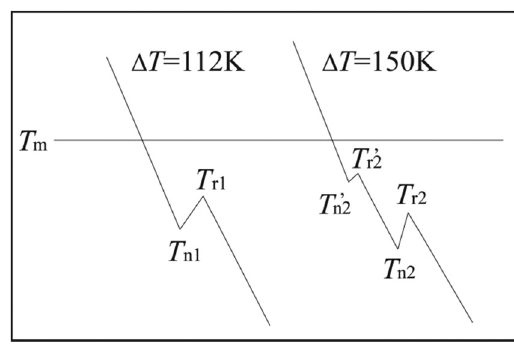
Figure 2: Cooling curves of Cu – 37.4 wt% Pb alloys at di ff erent undercoolings.